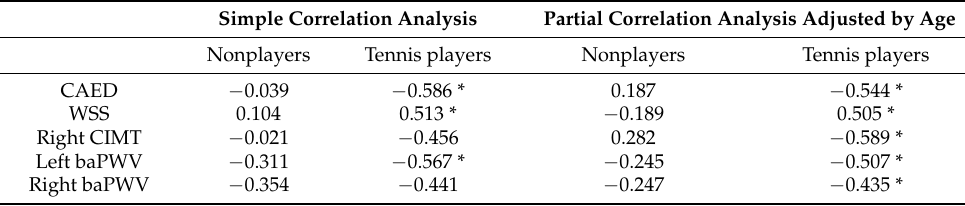
Table 4. Correlations between the FMD and the cardiovascular parameters. Simple Correlation Analysis Partial Correlation Analysis Adjusted by